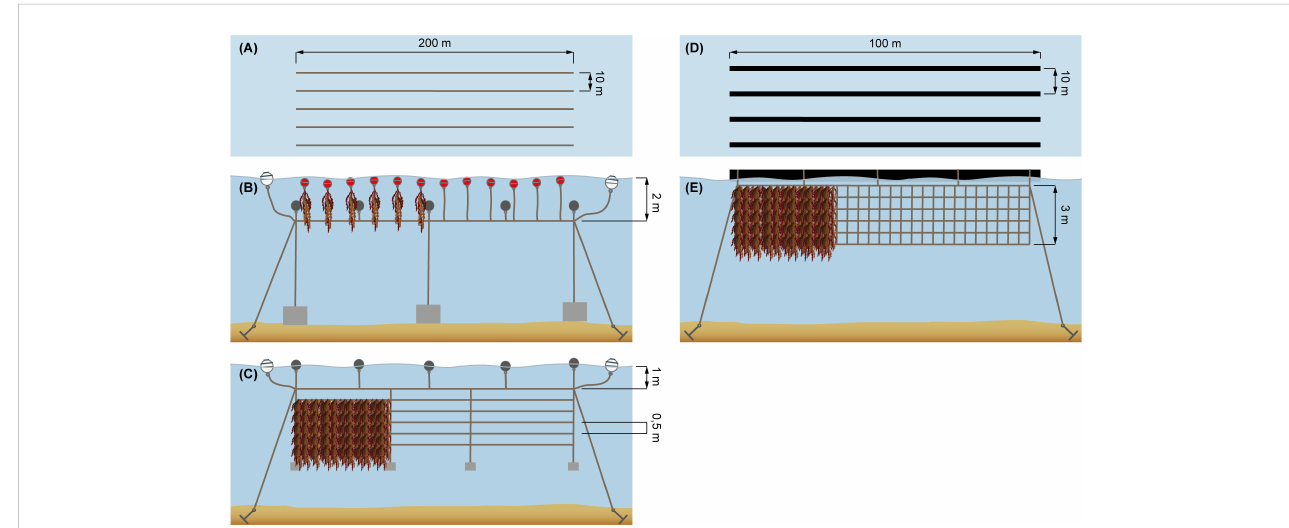
FIGURE 2 Overview of cultivation infrastructure designs used in this study. Line cultivation systems were based on using longlines of a length of 200 m. (A) the longline system seen from above; (B) the vertical line setup; (C) the horizontal 5-line setup; (D) the net cultivation system seen from above; and (E) the net cultivation setup. (A – C) are previously published as part of Boderskov et al. (2021a) and Zhang et al. (2022).